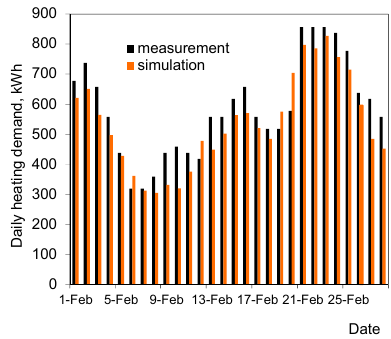
Figure 2. Measured and simulated daily heat demand in the residential building.